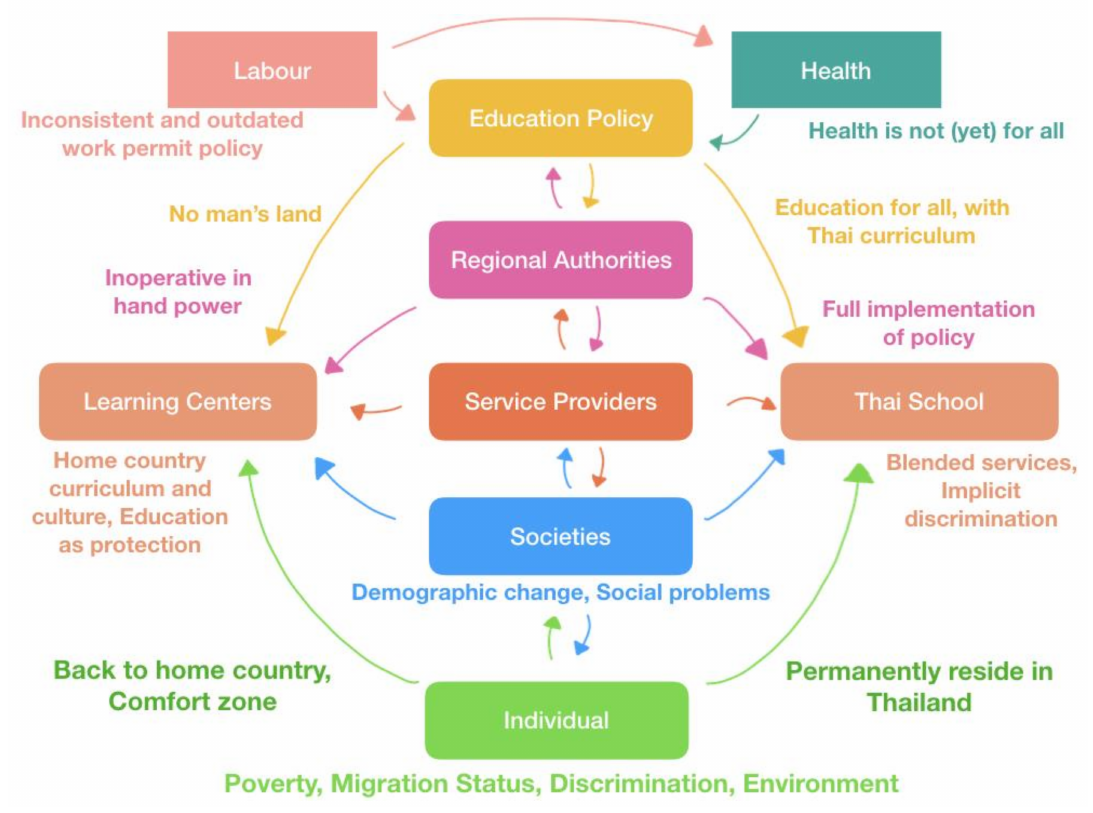
Figure 1. Relationships and determinants of health and access to education in migrant